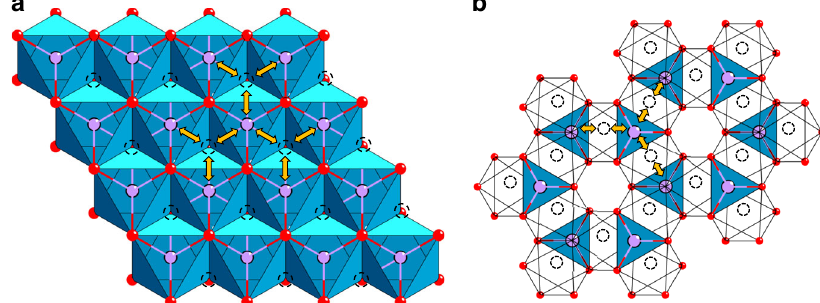
Fig. 3 Lithium-diffusion pathways with lower energy barriers in close-packed oxides. a Two-dimensional lithium diffusion from one octahedral site to another octahedral site in the lithium plane through a neighboring empty tetrahedral site in the O3 layered LiMO 2 cathodes. b Three-dimensional lithium diffusion from one 8a tetrahedral site to another 8a tetrahedral site through a neighboring empty 16c octahedral site in the spinel cathodes.